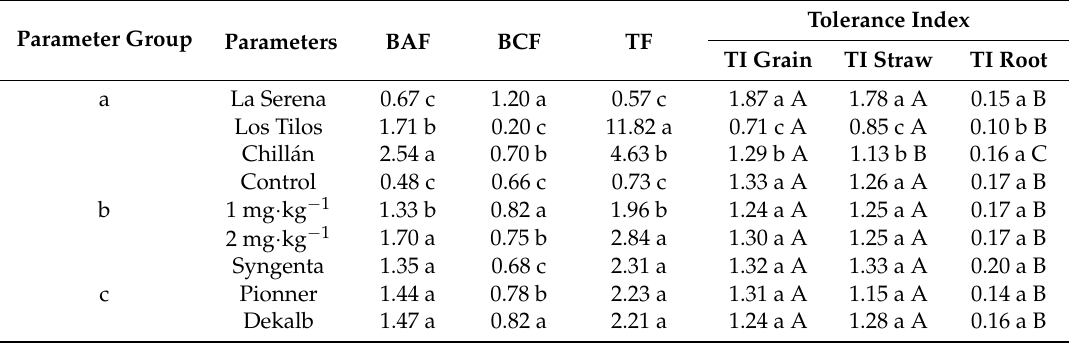
Table 6. Values for cadmium bioaccumulation factor (BAF), bioconcentration factor (BCF), translocation factor (TF), and tolerance index (TI) for grain, straw, and root according to different: (a) environments; (b) CdCl 2 rates; and (c) maize